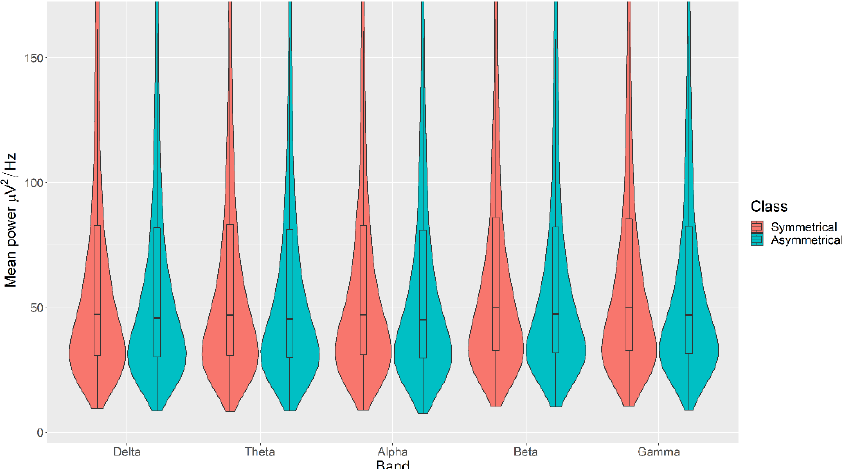
Figure 4. Violin plot of the average power in each of the bands for Symmetrical and Asymmetrical categories for the Balance VDEP, ranging from low ( δ delta) to high ( γ gamma) frequencies.